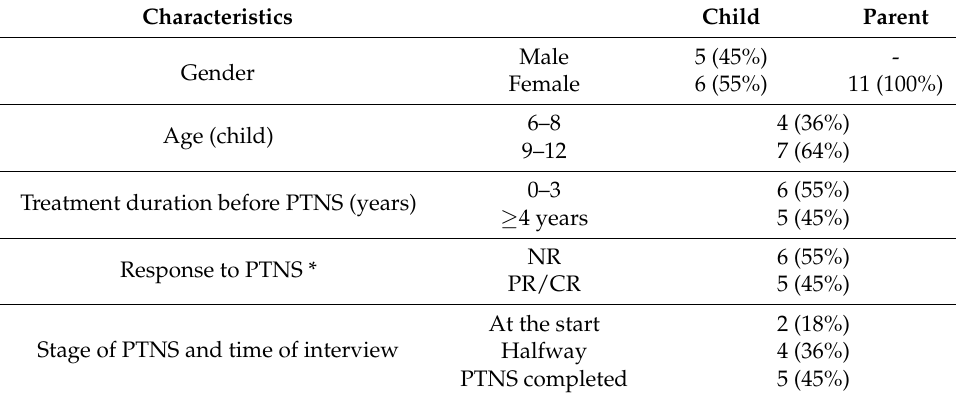
Table 4. Characteristics of the subjects interviewed (N = 11).